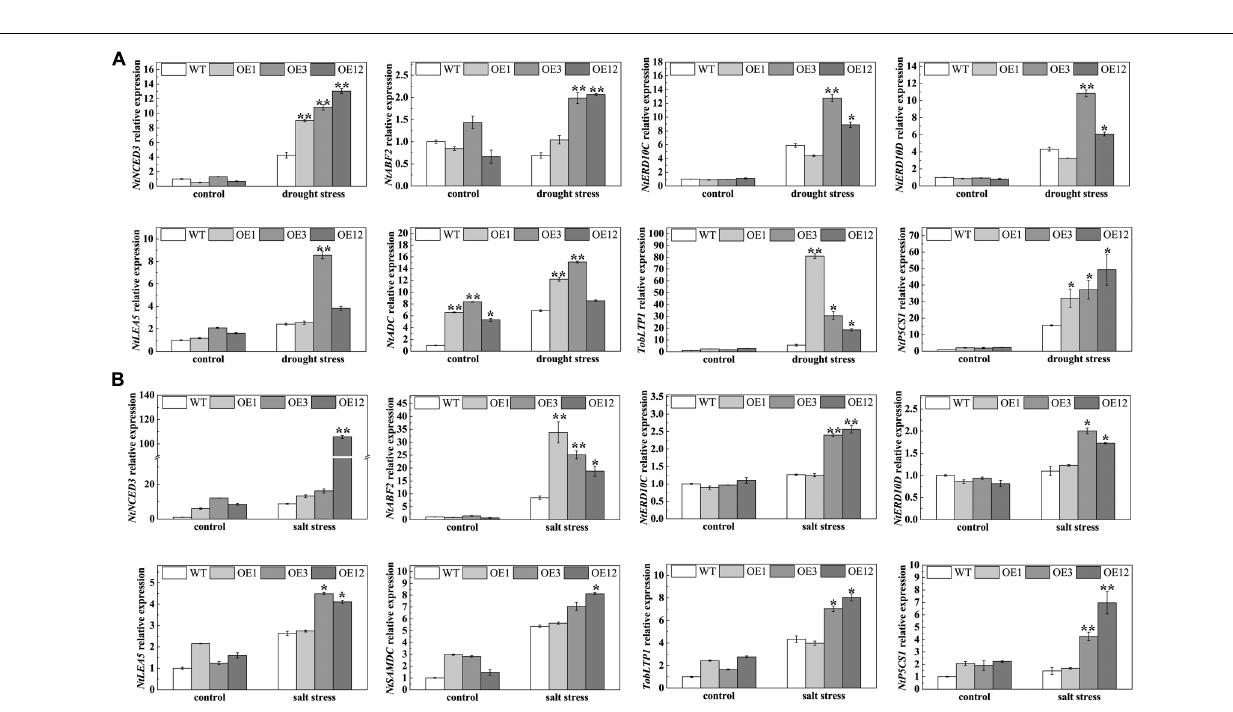
Frontiers in Plant Science |